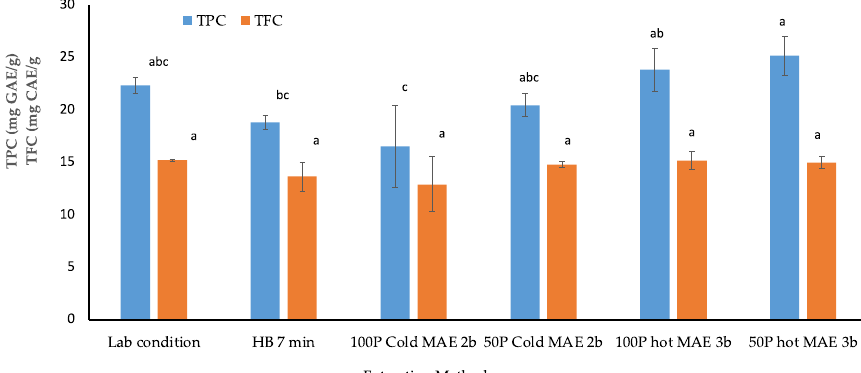
Figure 8. Levels of total phenolic content (TPC) and total flavonoids (TFC) of herbal tea infusion prepared from different extraction methods. Data are means ± standards deviations. Data for each